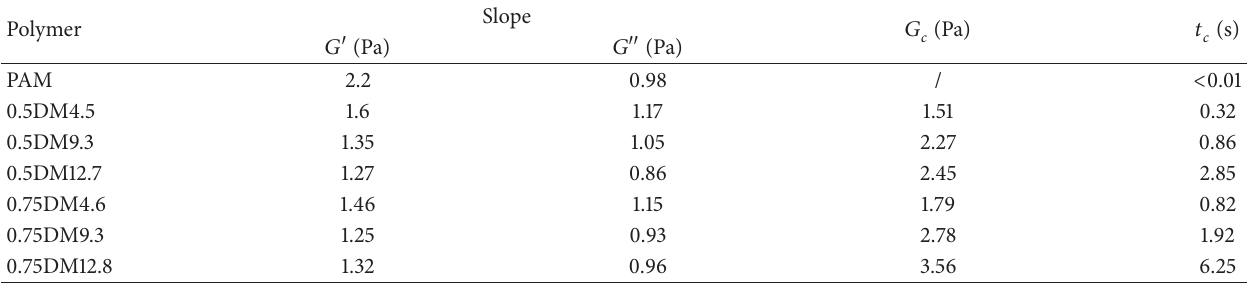
Table 3: Values of the slopes of the storage modulus 𝐺 󸀠 and the loss modulus 𝐺 󸀠󸀠 in the terminal zone and values of the crossing time 𝑡 𝑐 for the polymers.